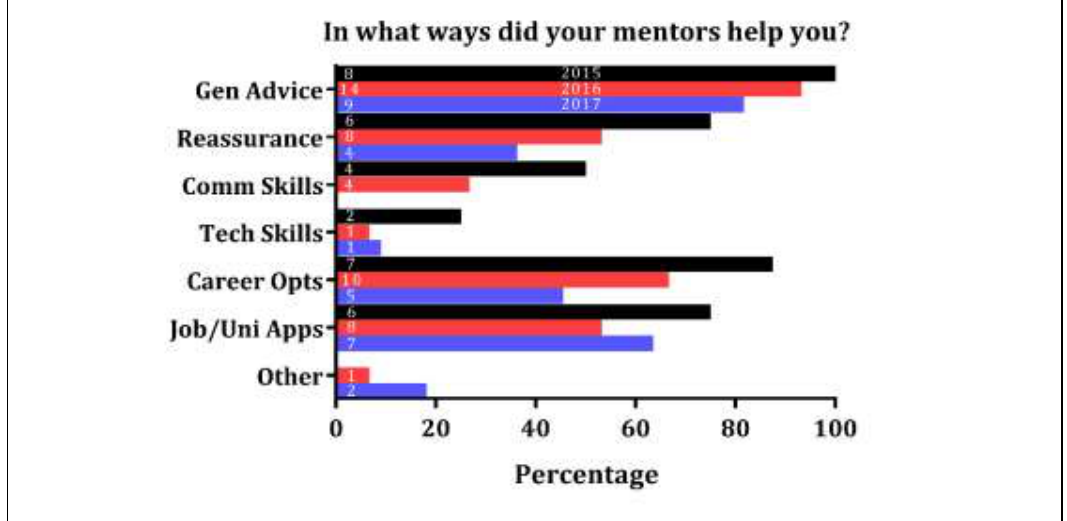
Figure 2. Percentage and number of mentees who received help in different ways